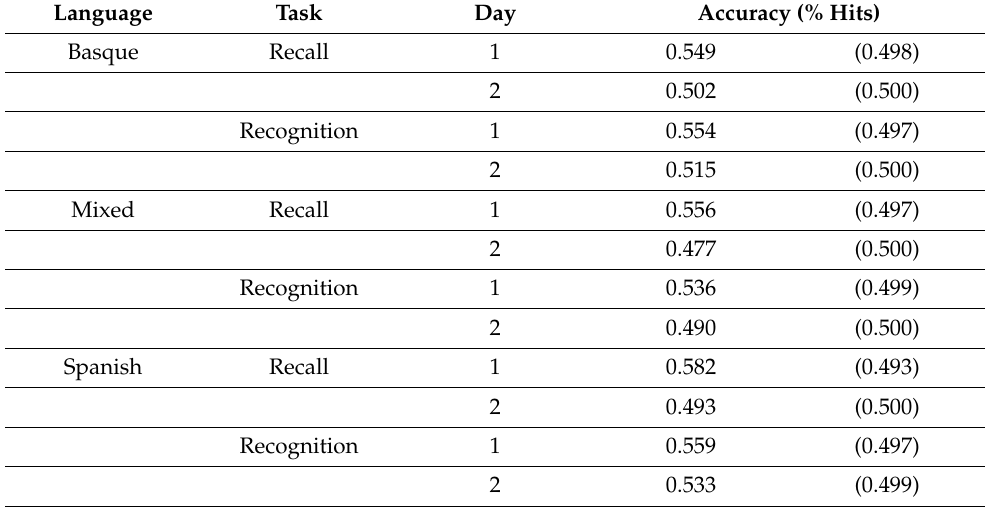
Table 2. Grand averages per language of exposition of correctly remembered items (Recall test) and correctly identified items (Recognition test) as a function of test day (Day 1 and Day 2). Standard deviations are presented in